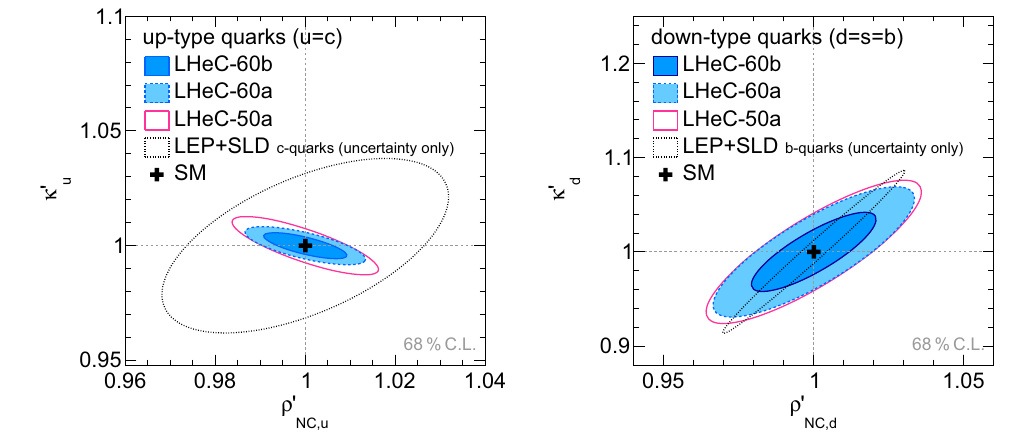
ties from LEP+SLD for charm-quark anomalous couplings. The right panel for down-type quarks shows a comparison of LHeC results with LEP+SLD [62] determinations of bottom-quark couplings